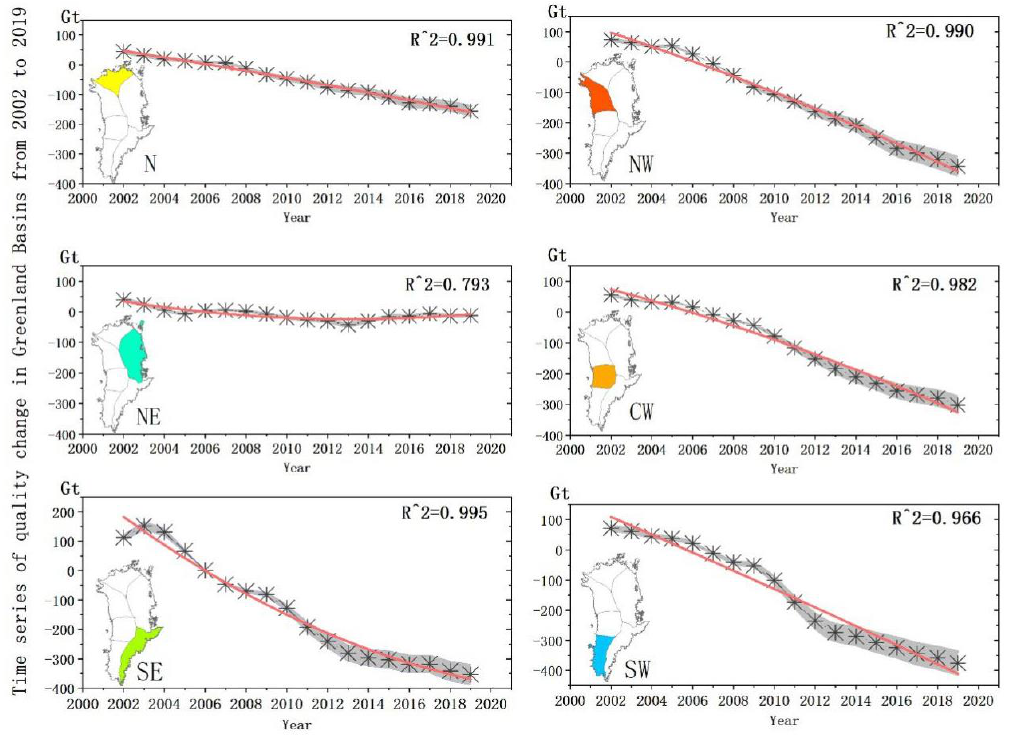
Figure 4. Greenland’s mass change in different watersheds from 2002 to 2019 .